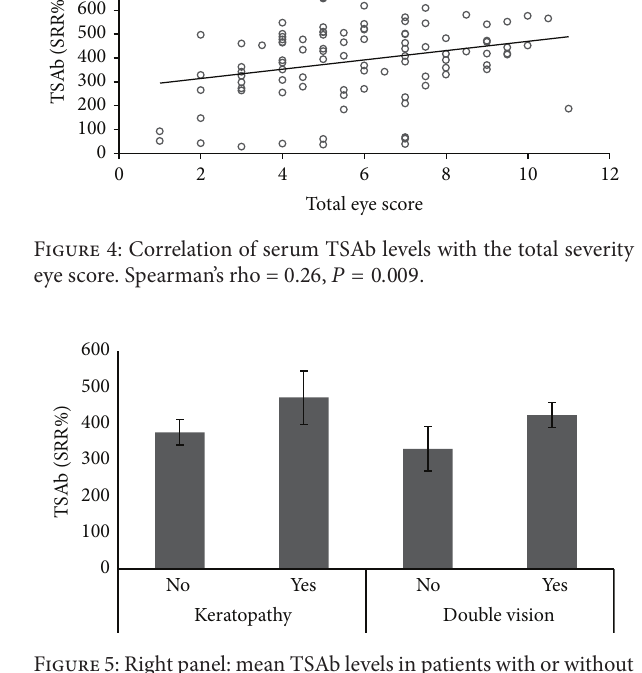
Figure 5: Right panel: mean TSAb levels in patients with or without diplopia (Mann-Whitney U test; 𝑃 = 0.023 ); left panel: mean TSAb levels in patients with or without corneal lesions (keratopathy, Mann-Whitney U test; 𝑃 = 0.042